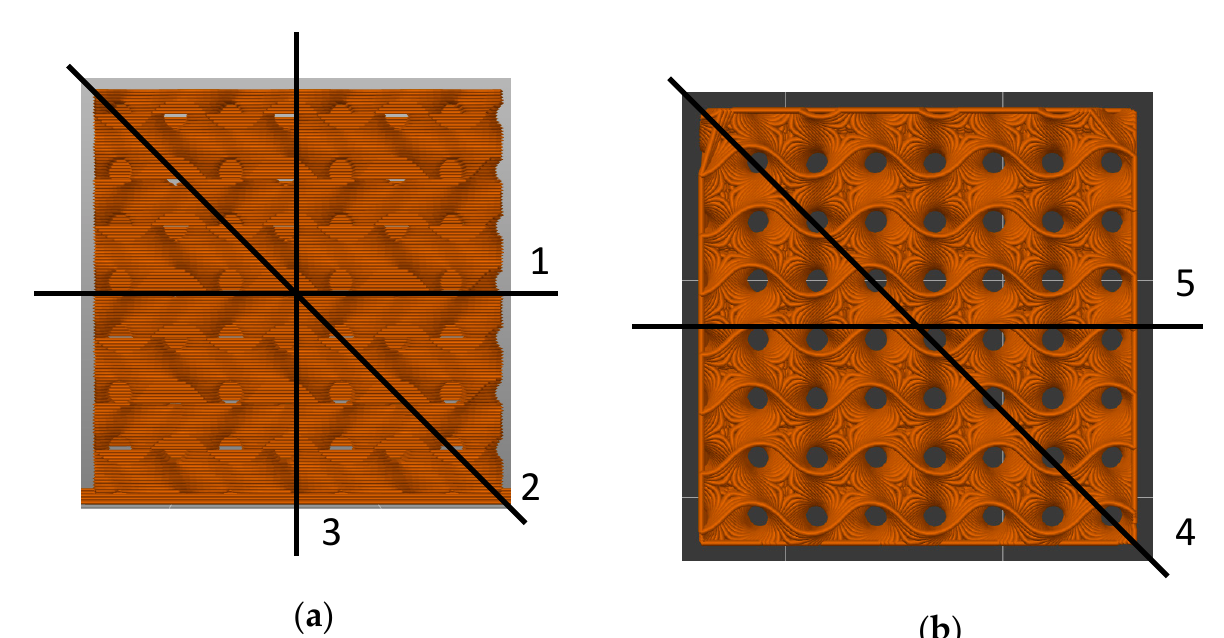
Figure 1. Front ( a ) and top view ( b ) on the gyroid sample with 20% infill. The lines along which a pressure was applied are defined as follows: (1) front horizontal, (2) front diagonal), (3) front vertical), (4) top diagonal, (5) top parallel to the front edge.